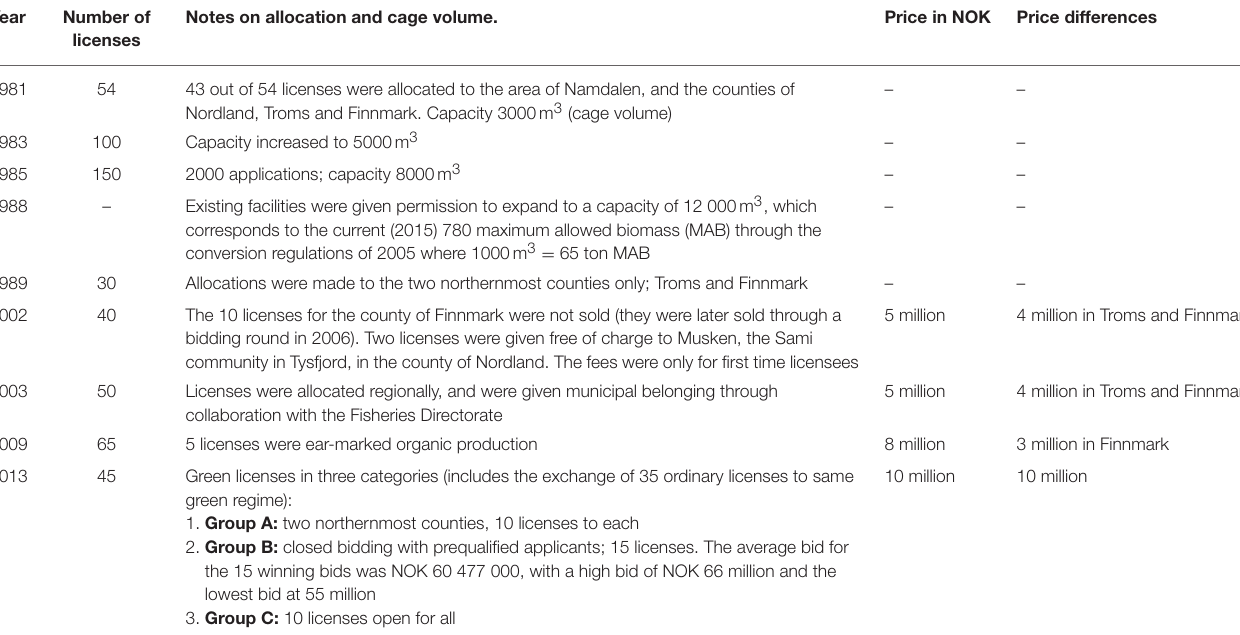
TABLE 1 | Overview of rounds of aquaculture license allocations by the Norwegian government after the first Aquaculture Act of 1981.